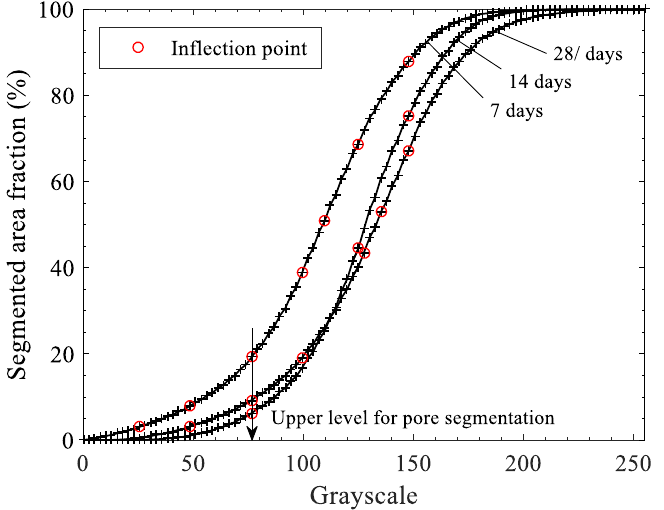
Figure 7. Determination of threshold level between pore and solid (OPC paste was used for the example).